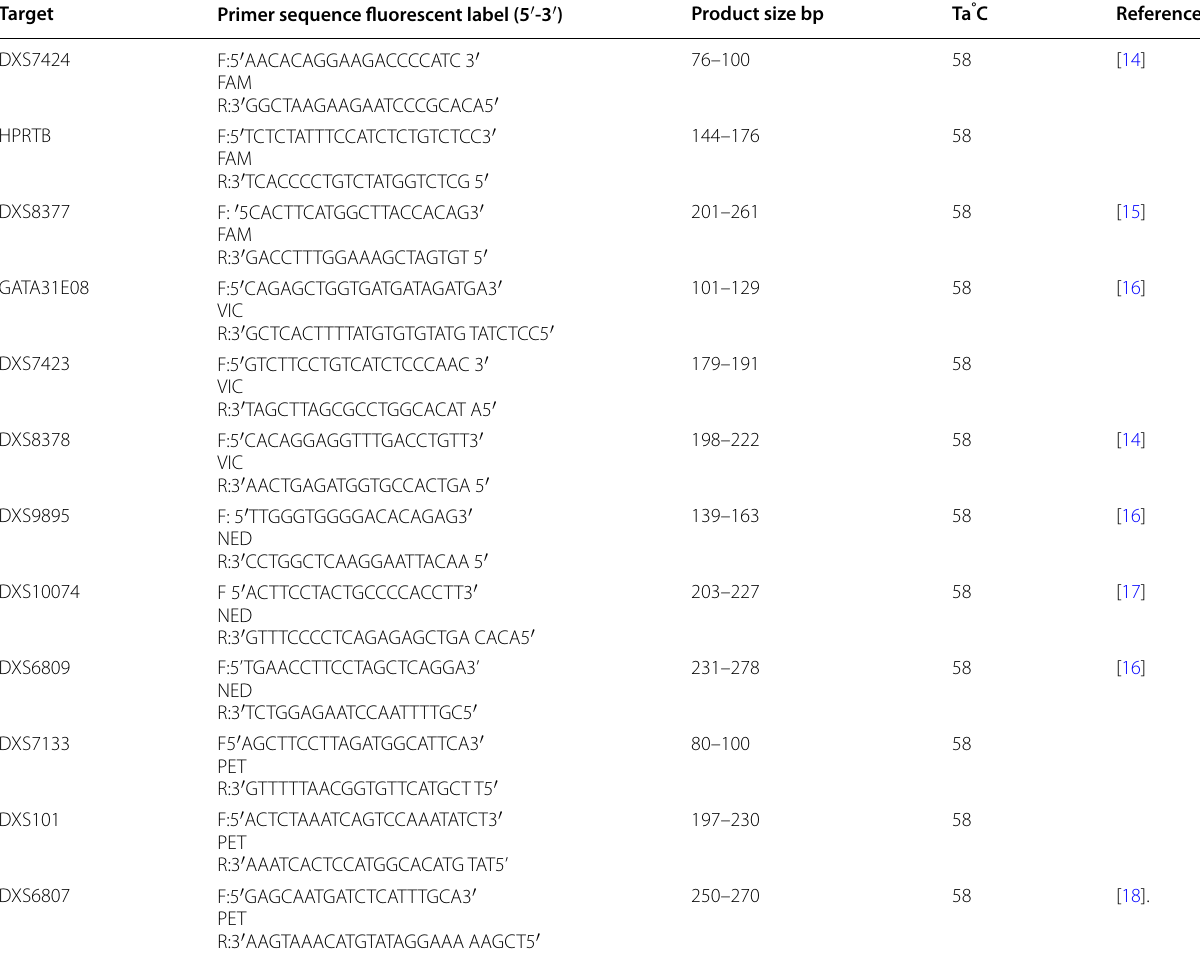
Ta(C°) annealing temp